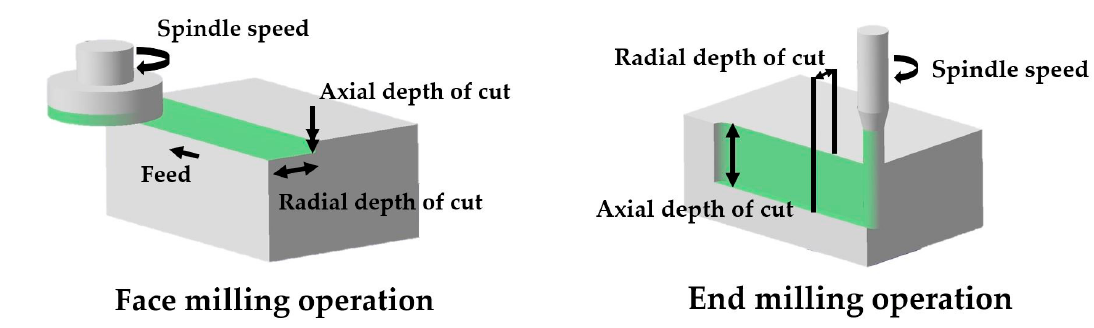
Figure 1. Milling operations.